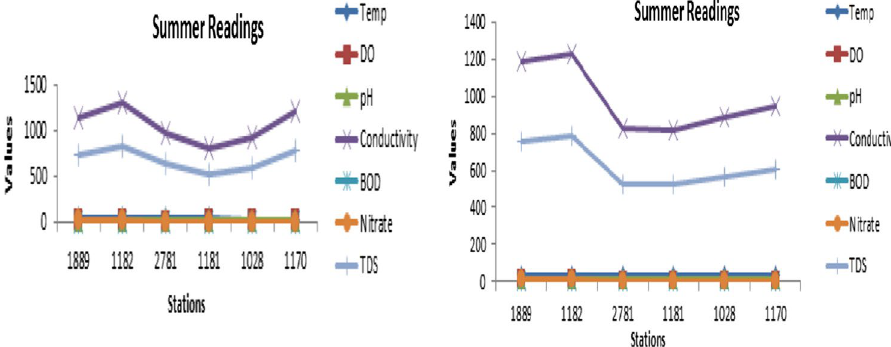
Fig. 5 Yearly variations of different water parameters in summer season for year 2008 and